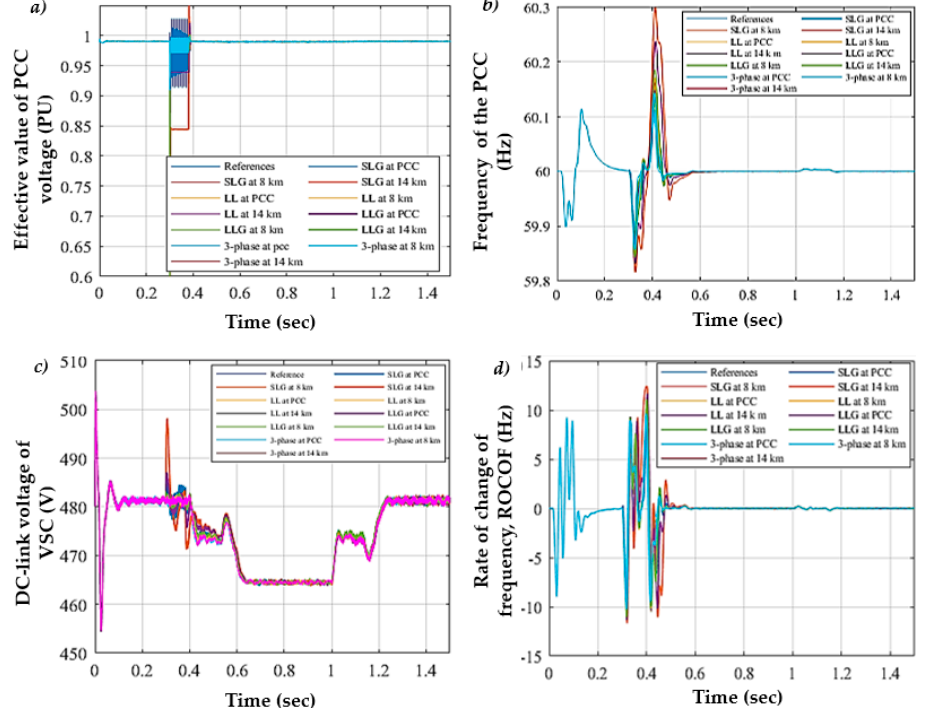
Figure 14. Simulation case of different fault events, ( a ) the effective voltage value at the point of common coupling; ( b ) variation of the frequency at the point of common coupling; ( c ) the dc-link voltage of voltage source control; ( d ) rate of change of frequency in fault event for non-islanding.